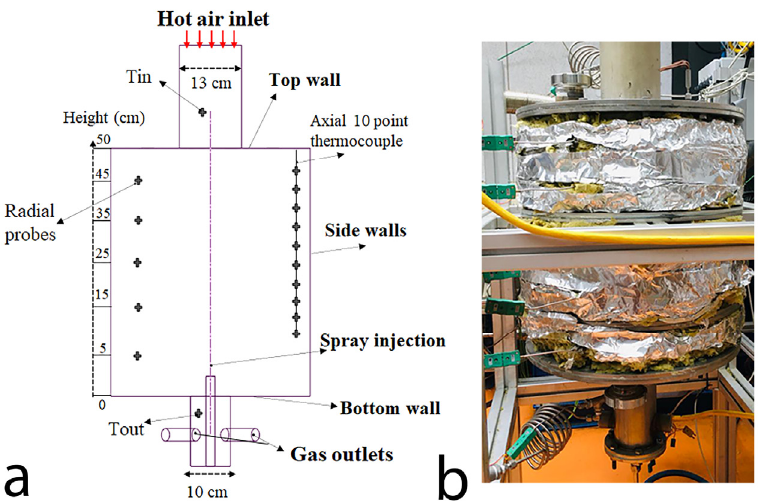
Figure 1. Schematic overview of the reactor depicting inlet, outlet, walls, and probes locations ( a ) and lab-scale counter-flow spray dryer ( b ) .